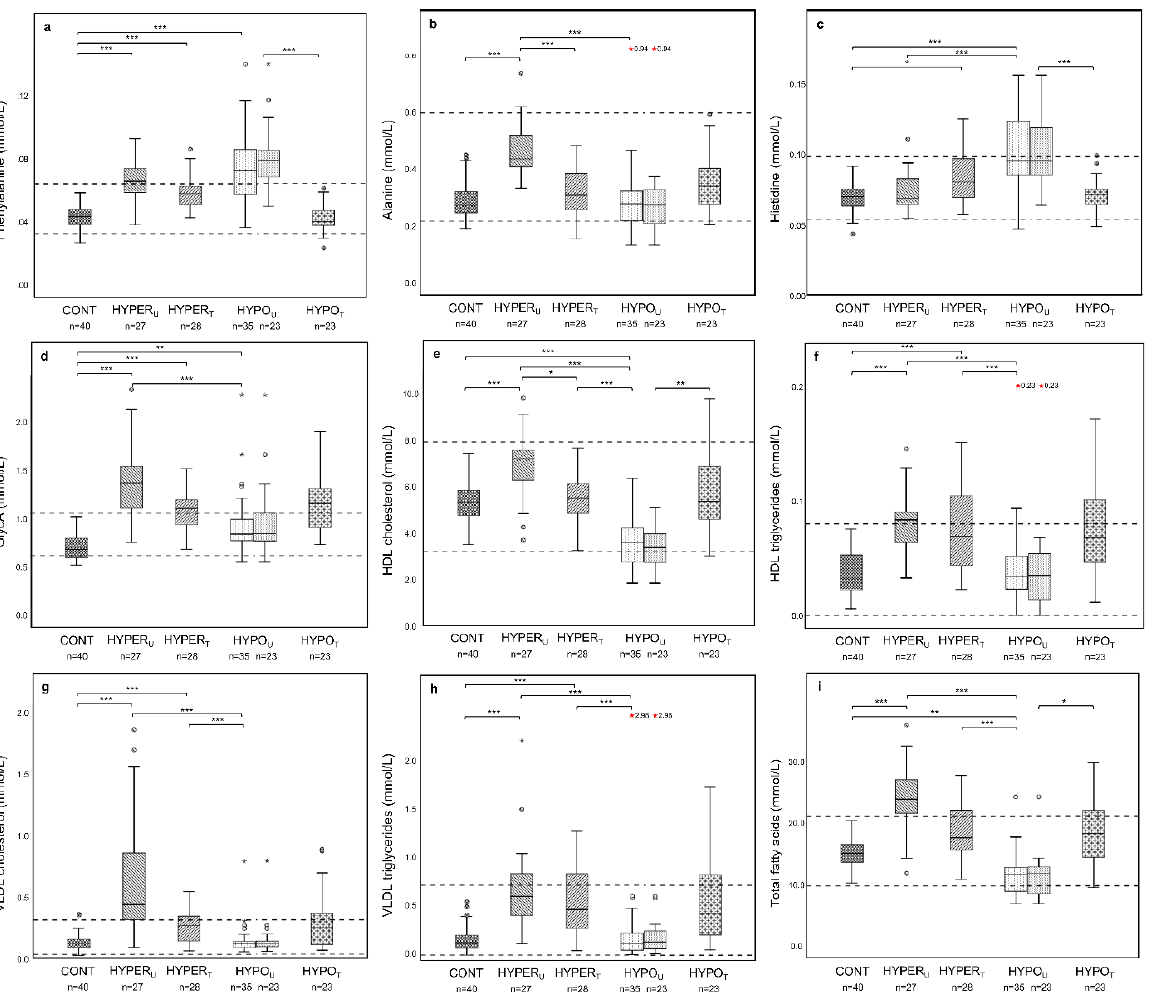
Figure 4. Concentrations (mmol/L) of phenylalanine ( a ), alanine ( b ), histidine ( c ), glycoprotein acetyls (GlycA) ( d ), high-density lipoproteins (HDL) cholesterol ( e ), HDL triglycerides ( f ), very-low-density lipoproteins (VLDL) cholesterol ( g ), VLDL triglycerides ( h ), and total fatty acids ( i ) in samples from dogs in the groups of CONT, HYPER U , HYPER T , HYPO U , and HYPO T . The boxes of the HYPO U group are presented both from the unpaired group utilized in multivariate analyses ( n = 35, left) and the paired group ( n = 23, right) utilized in comparison of HYPO U and HYPO T groups. Boxes indicate the lower to upper quartile (25th – 75th percentile) and median value. Whiskers extend to minimum and maximum values. Outliers are shown as individual open circles or stars. Dashed lines indicate reference intervals. Lines above figures reflect significant differences between specific groups (* p < 0.05; ** p < 0.01; *** p < 0.001). Note: CONT — control group; HYPO U — hypoadrenocorticism untreated; HYPO T — hypoadrenocorticism treated; HYPER U — hyperadrenocorticism untreated; HYPER T — hyperadrenocorticism treated.